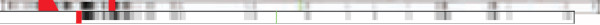
A comparison of the data in figure 3B (upper line) and the original (incorrect) supplementary fig. S3B (lower line) in the Fuller et al. [2] paper, on the day in which fig. S3B contained a "gap". The images have been cut directly from the online figures, resized to cover the same time period, and aligned by eye. The red vertical lines marking the feeding time (the offset in the incorrect figure S3B due to not being corrected for the correct time of day) are clear. A piece of a red arrow that marks the food deprivation day is also seen toward the left in the upper register. The "gap" period is the blank area to the left of the red line in the lower register. Note that the lower register (the day in which mean body temperature was 0.06°C lower because of the missing data in the gap period) shows more time periods when the body temperature exceeded the mean (marked by gray or black boxes, depending upon how high the temperature was). Although the differences are subtle, the two plots do not "appear to be identical" as claimed by Mistlberger [1].